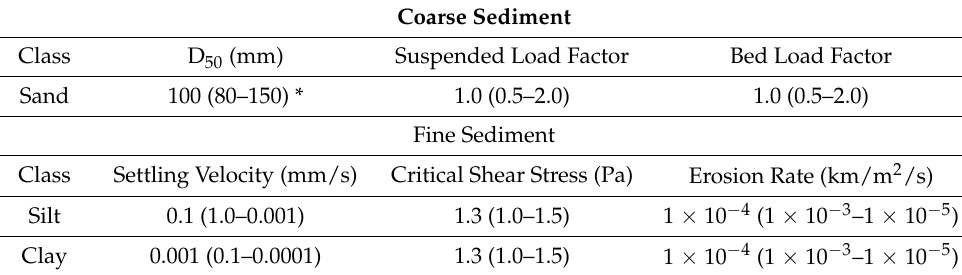
Table 1. The calibrated values of sediment